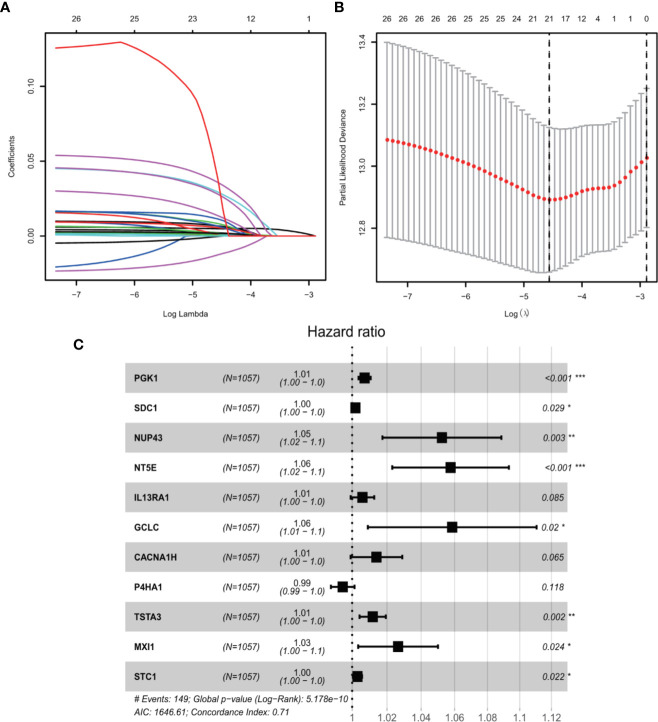
GRGs selection using the LASSO model and multivariable Cox model. (A) Ten-fold cross-validation for the coefficients of 326 GRGs in the LASSO model. (B) X-tile analysis of the 21 selected GRGs. (C) Forest plot illustrating the multivariable Cox model results of each gene in 11-GRG risk signature.